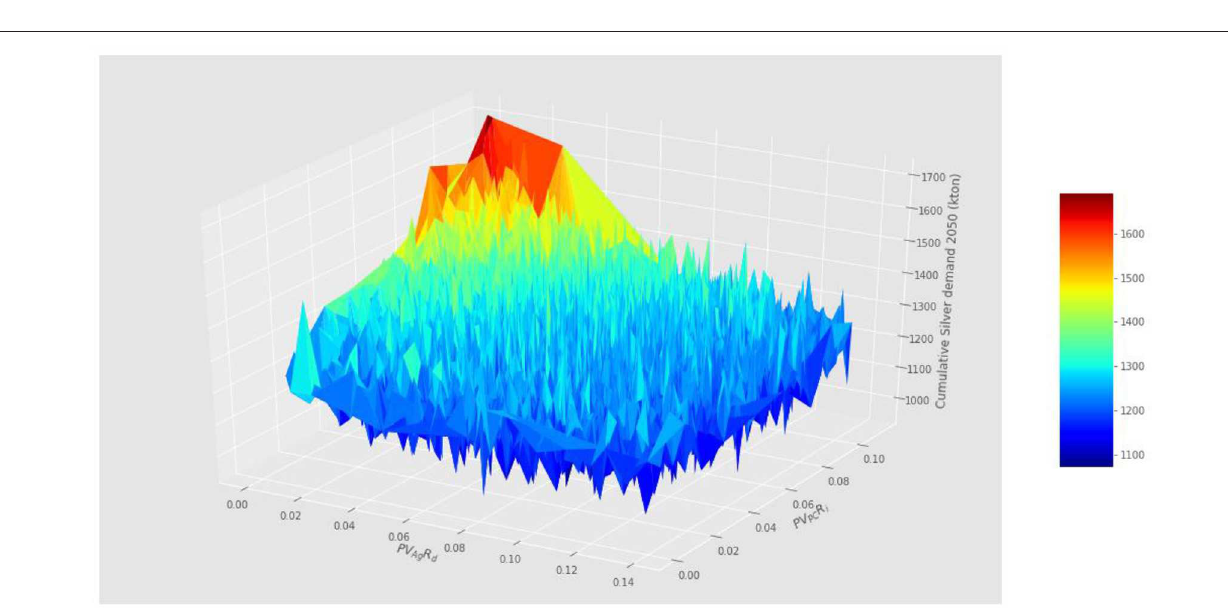
FIGURE 9 | Cumulative silver demand (kton) in 2050 against decreasing pace in silver use for PV cell contact metallization and increasing pace of PV power capacity installed. Monte Carlo simulations run on 8,192 quasi-random